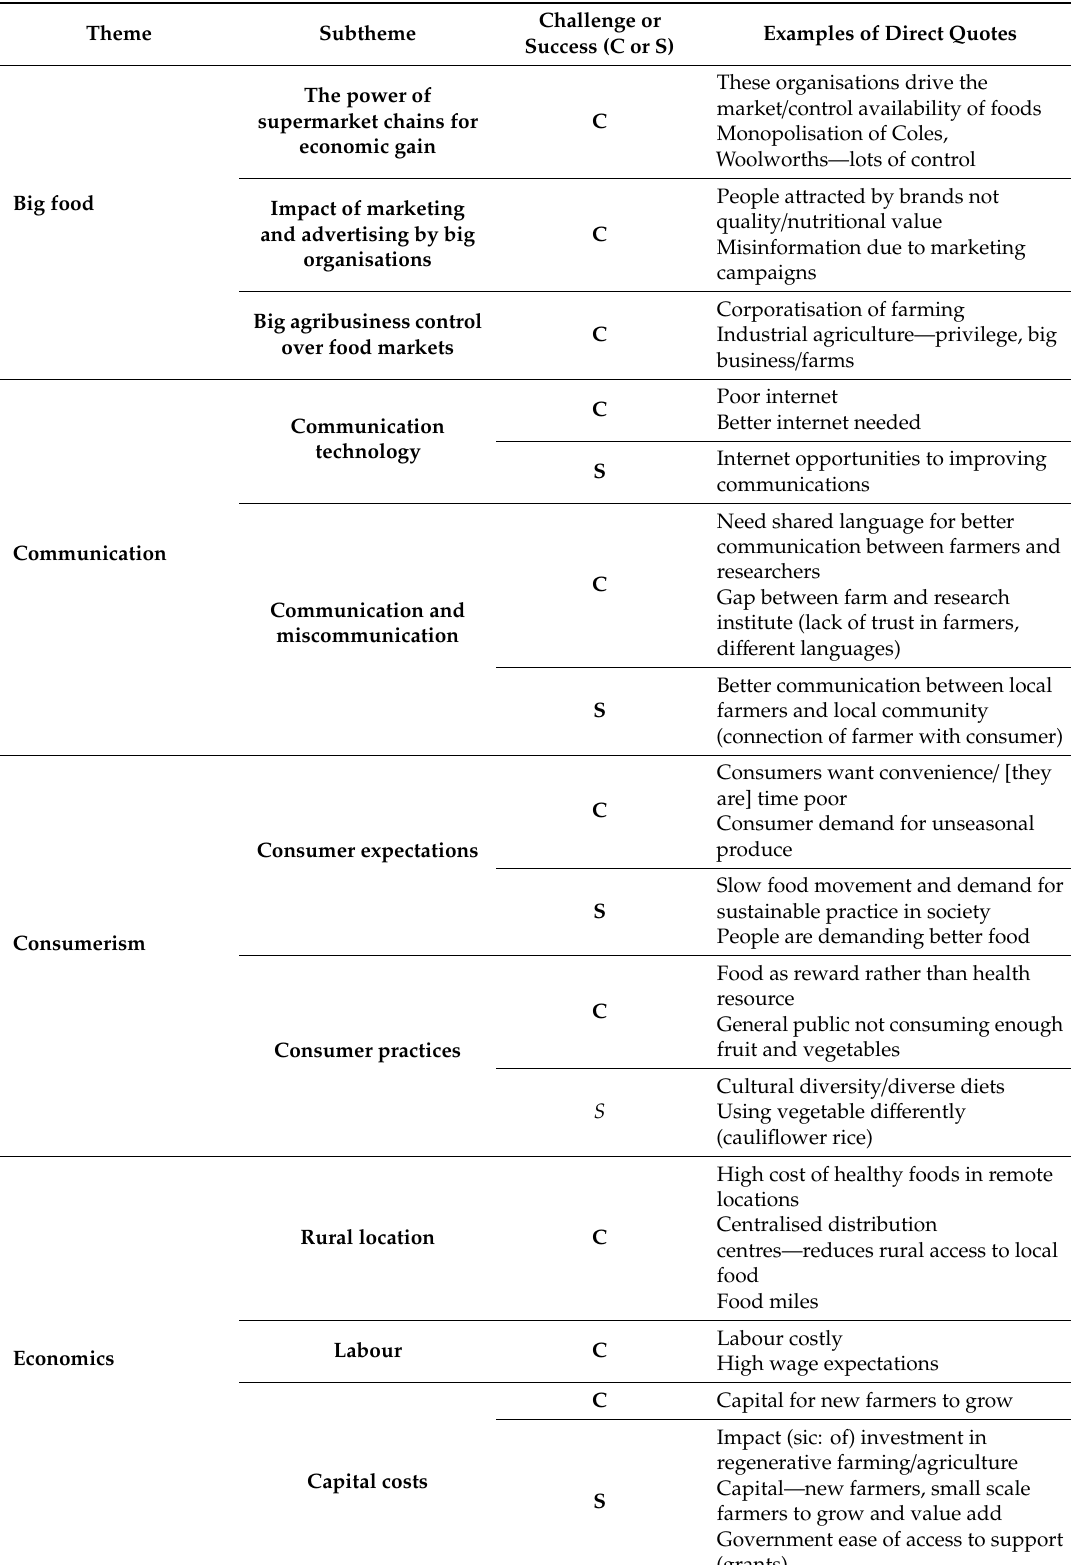
Table 4. Cross-cutting themes, embedded sub-themes and exemplar